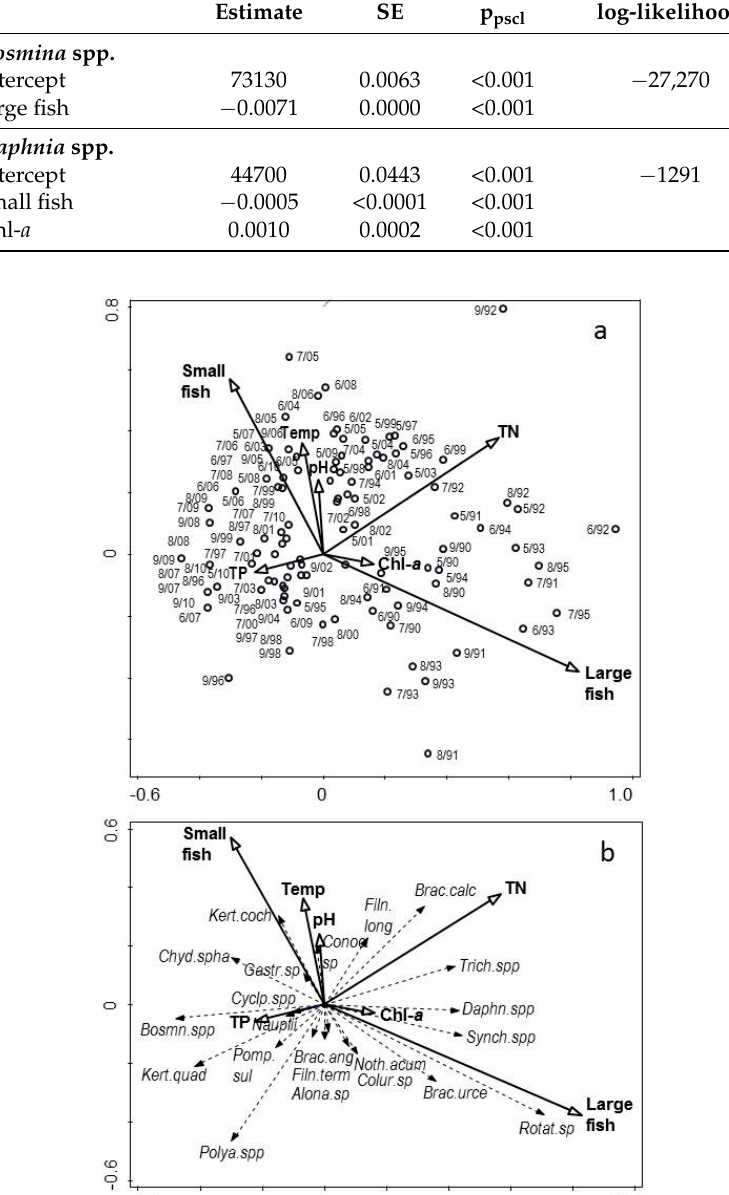
Table 2. Multiple GLMMs based on Markov chain Monte Carlo method showing the predictors for the changes in the abundance (ind. L − 1 ) of Bosmina spp. and Daphnia spp. for the summer period. Estimated value, standard error (SE), p ‐ value (p pscl ), and log ‐ likelihood.